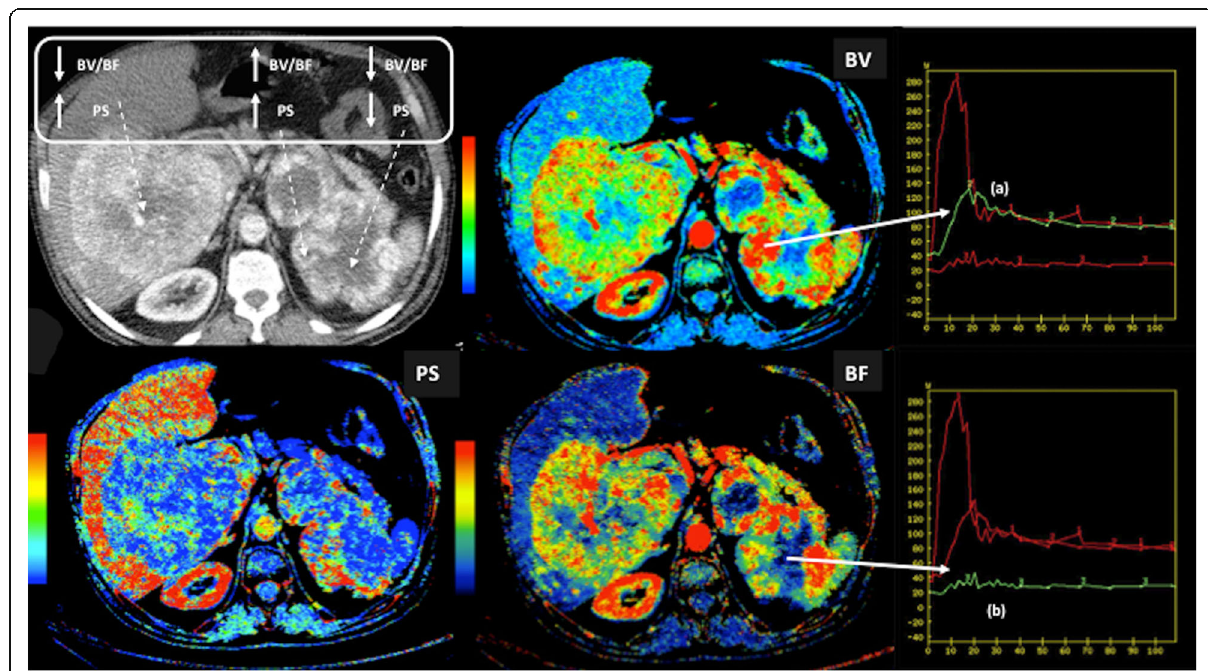
Fig. 18 Perfusion CT exam in a 42-year-old man with a metastatic renal carcinoma. Blood flow (BF), blood volume (BV), and permeability (PS) parametric maps evidenced the heterogeneity of the functional status of the vasculature within the tumor with several combinations of the obtained parameters (top-left) and clear differences between the time density curves coresponding to the peripheral areas of viable tumor with increased BV, BF, and PS ( a ) with a wash-in/wash-out pattern and the central necrotic necrotic areas ( a